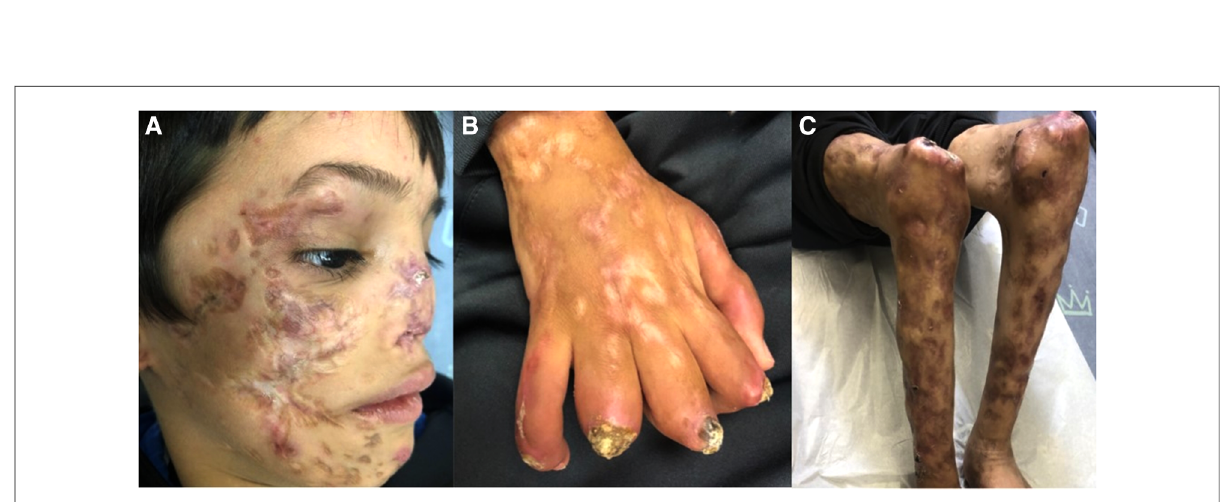
FIGURE 3 ( A – C ) Clinical features on his last follow up at the age of 9-years. Dyspigmented atrophic plaques on the cheeks, nose, chin and lateral upper eyelidswith deformity and scarring. Dystrophic and wasted saddle nose ( A ). Right hand showing ulcerated plaques covered with thick crust and scale, dyspigmented atrophic scars and contractures of fi ngers ( B ). Muscle wasting and dyspigmented atrophic scars on the lower limbs, ulcerated plaques and swelling of the knees ( C